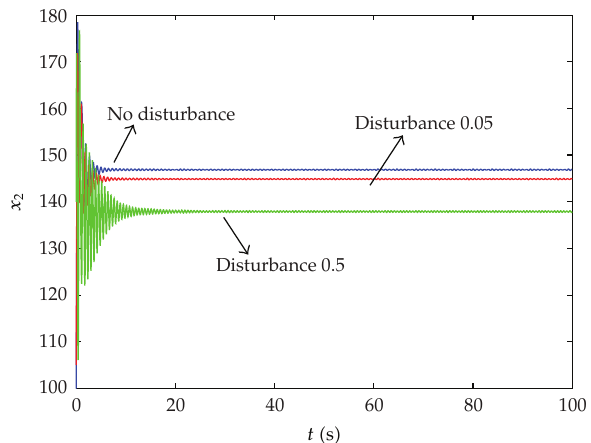
Figure 8: Trajectories of the state variable x 2 by T2ABFC with external